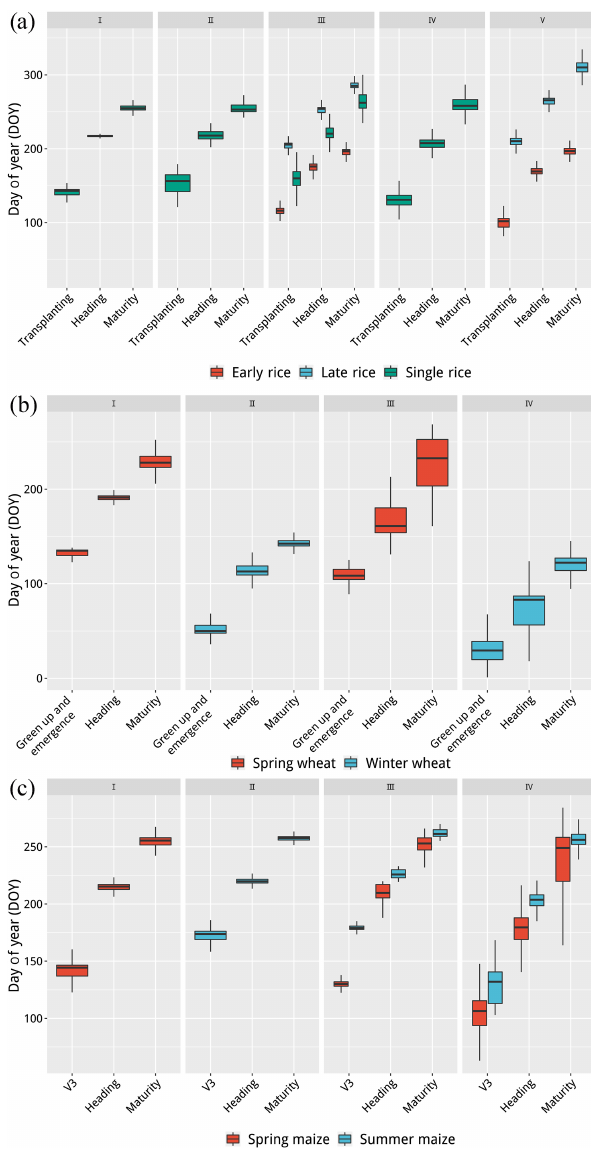
Figure 7. Box plots of three key phenological dates by crop and subregions during 2000–2015 for rice (a) , wheat (b) and maize (c) . observations at the site scale (Tao et al., 2012, 2013, 2014; Zhang et al., 2014b).